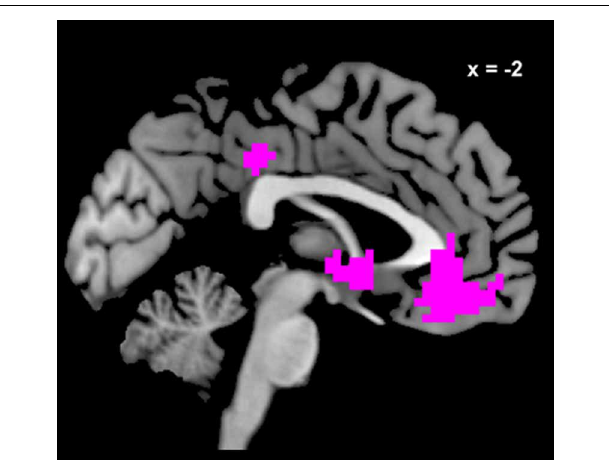
FIGURE 2 | Voxels in meta-analytically defined reward value regions whose pattern of activity is better explained by a GLM including dSV as a regressor than a reduced version of the GLM omitting dSV. Voxels in violet are those within a mask of reward value sensitive regions including vmPFC, vStr, and PCC created from recent meta-analyses on reward value computation (Bartra et al., 2013; Clithero and Rangel, 2013) where the exceedance probability for GLM-dSV compared to the reduced version without dSV is 0.90 or higher. The exceedance probability was 0.90 or higher for the version of GLM-dSV including dSV in 83% of voxels within the meta-analysis